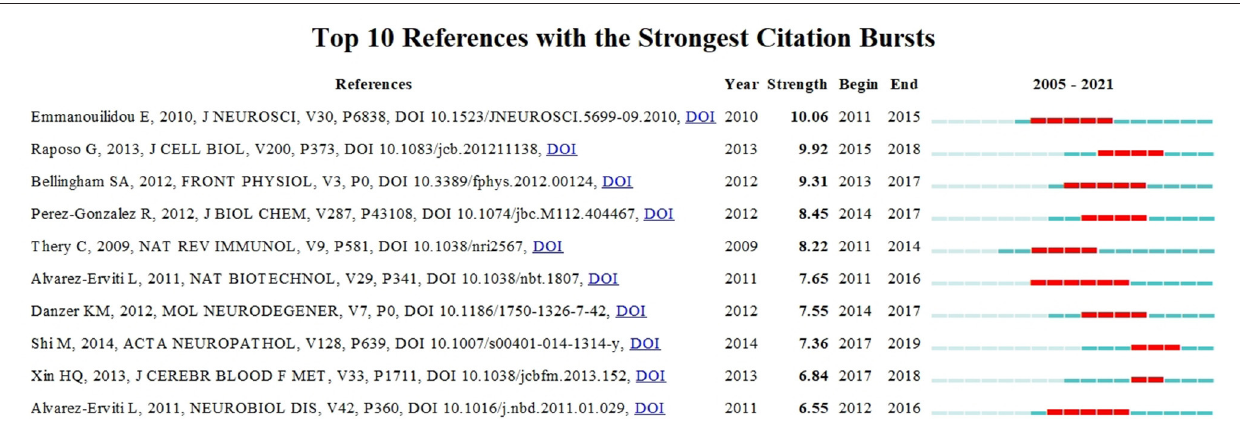
Frontiers in Neurology |